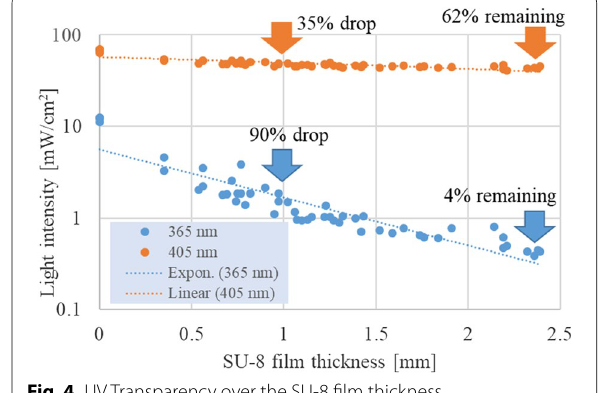
Fig. 4 UV Transparency over the SU-8 film thickness